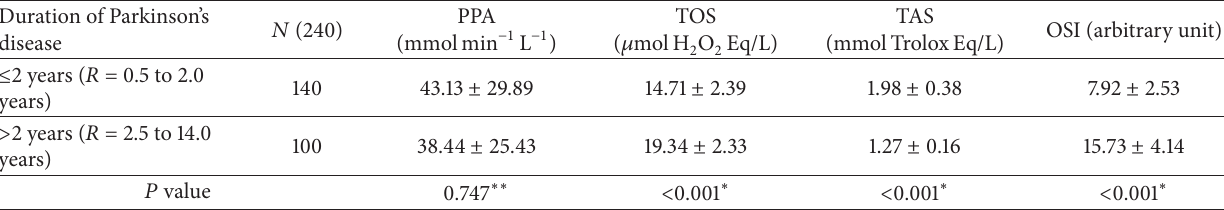
Table 2: Representation of PPA, TOS, TAS, and OSI with duration of disease in patients with PD. Duration of Parkinson’s